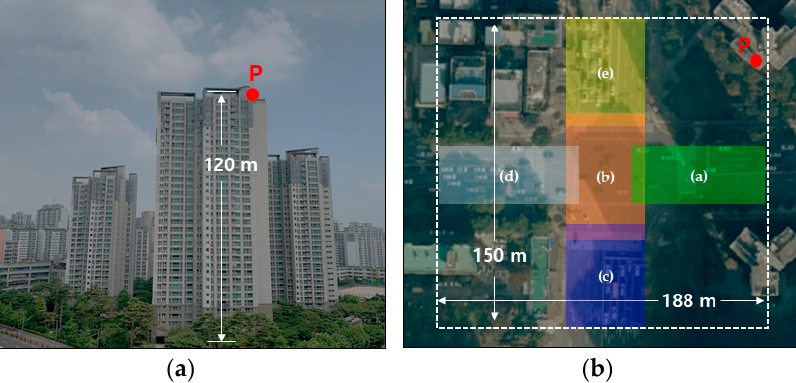
Figure 1. Camera location P at R apartment in South Korea ( a ); orthogonal crossroad map ( b ).